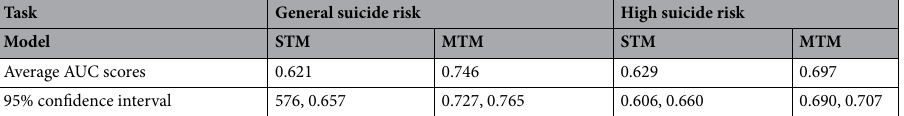
Table 3. Detection performance (average AUC scores) of the STM and MTM ( N = 1002). STM single task model, MTM multiple tasks model, AUC area under the receiver operating characteristic curve, Average AUC scores the average scores of the five AUC scores that were obtained in the cross-validation